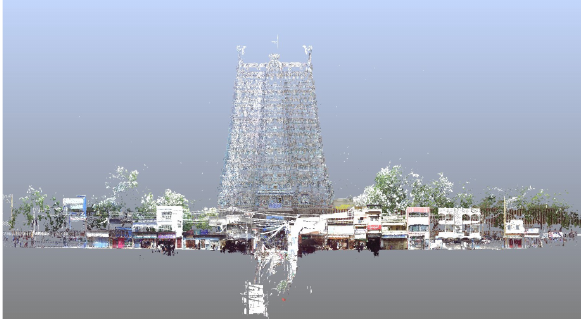
Figure 6. Orthophoto of TLS showing front elevation